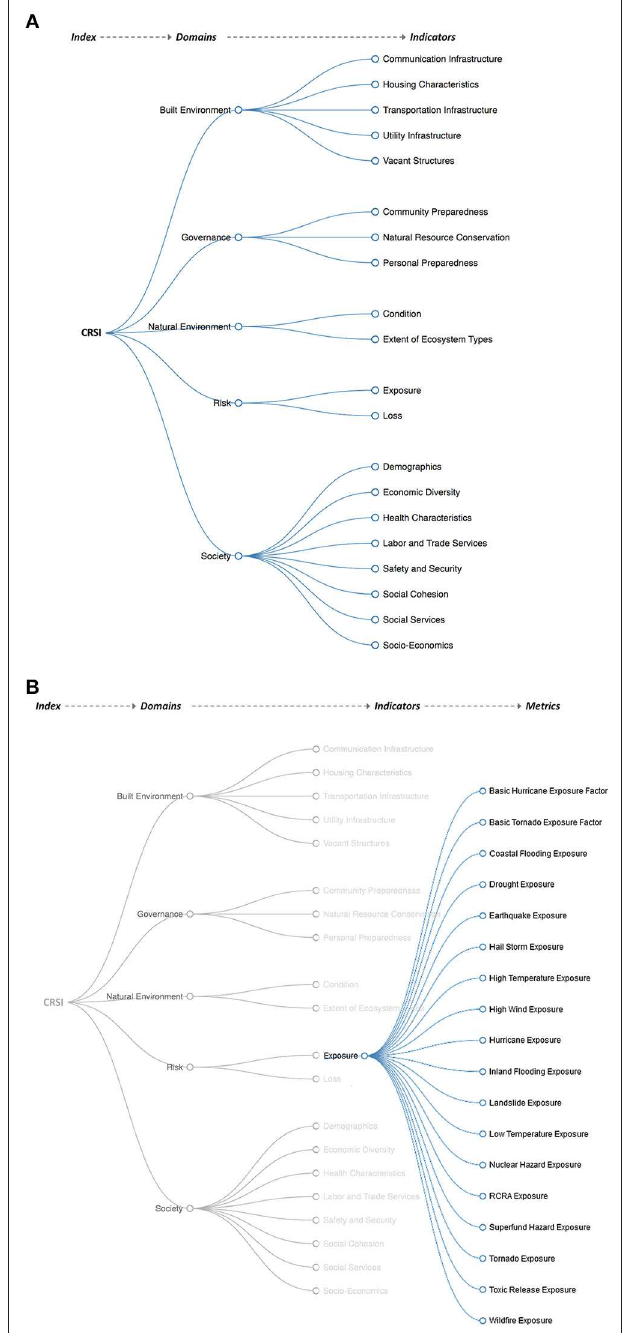
FIGURE 3 | (A) The CRSI-domain-indicator data tree that served to inform the organization of different aggregates of indicator values. (B) A continuation of the CRSI data tree depicting the relationship between one indicator and associated metrics (processed data).